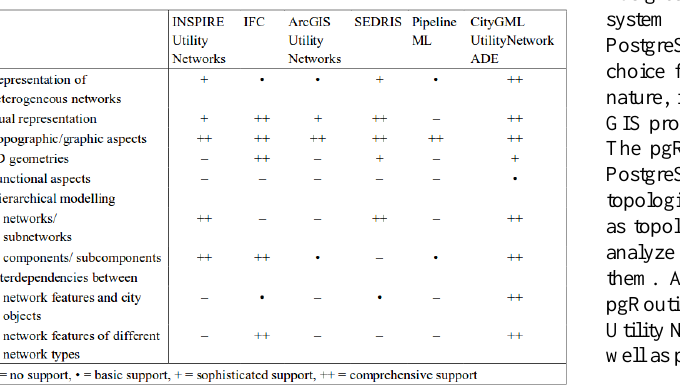
Table 1. Levels of support for various utility network modelling systems. Table source: Kutzner and Kolbe